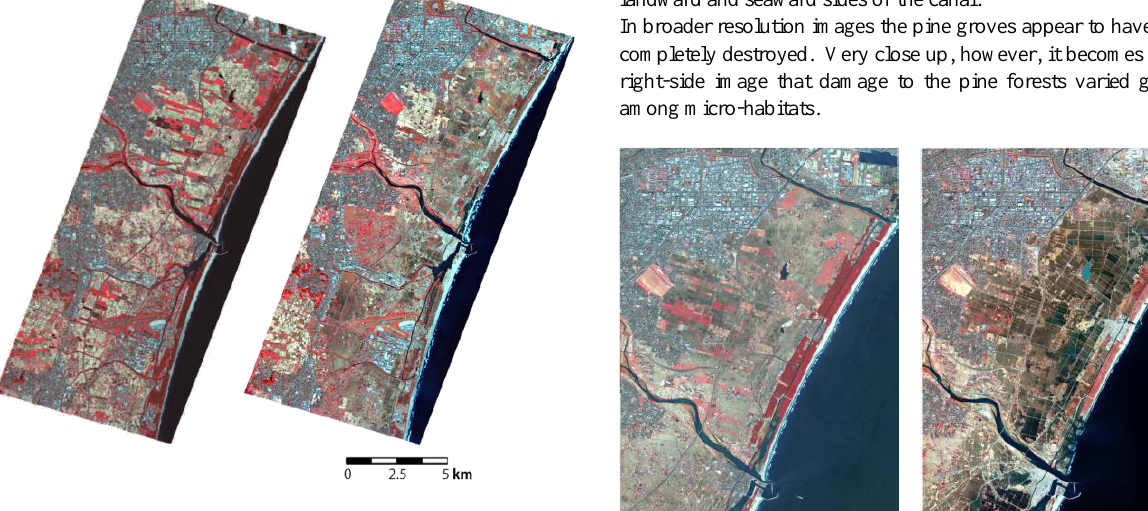
Figure 4(a). SPOT/HRG-2 images for the Sendai Bay area, before (left: 2 nd September 2010) and after (right: 2 nd November 2011) the disaster. R:G:B=3:2:1 © CNES 2010-2011, Distribution Astrium Service/Spot Image S.A.